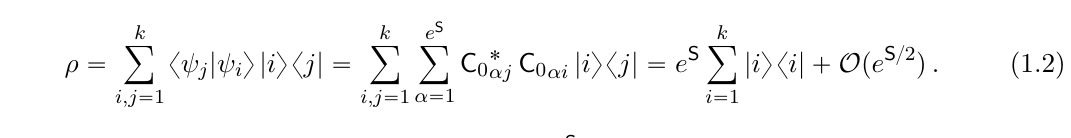
Figure 1 . Normalized version of the density matrix (1.2) for k right). Orange is positive and blue negative. Intensity of colors reflects the magnitude of individual matrix elements. Off-diagonal elements are less/not suppressed for black holes that have almost evaporated